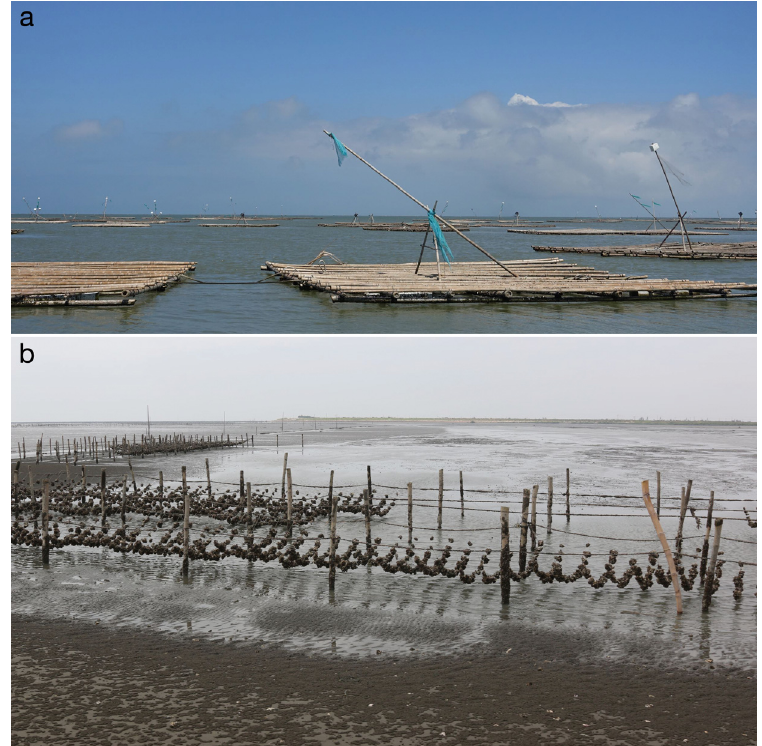
Fig. 2. Examples of oyster aquaculture in Taiwan: (a) floating racks and (b) cradle